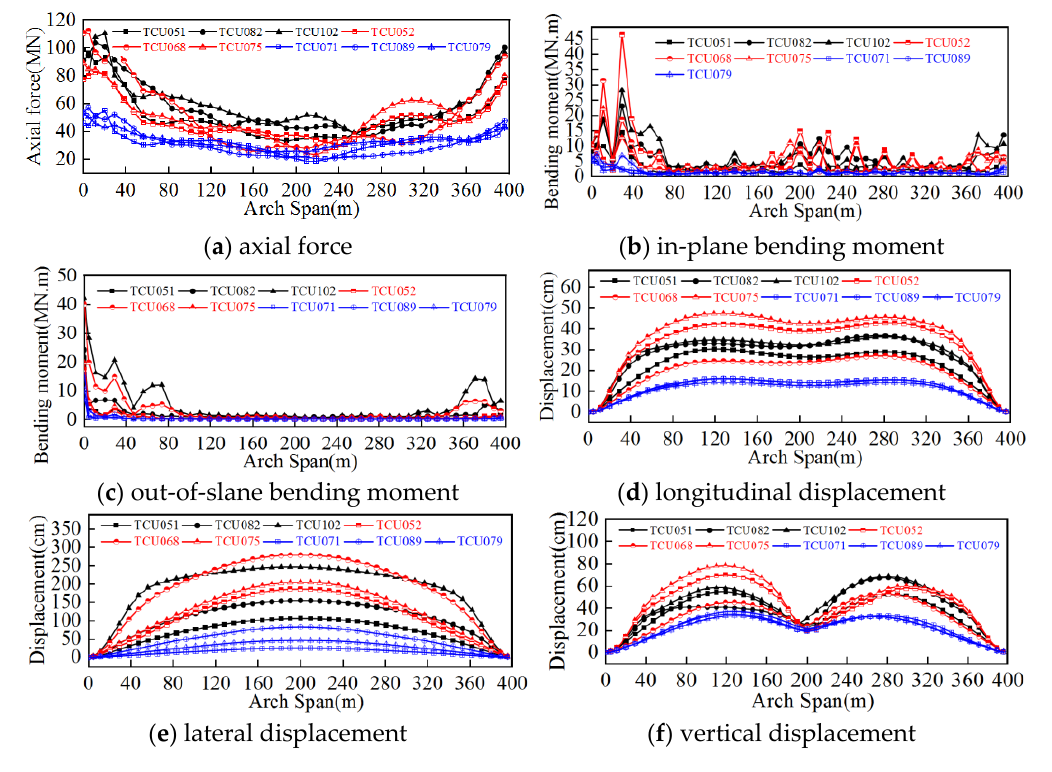
Figure 6. Envelope results of arch rib response.